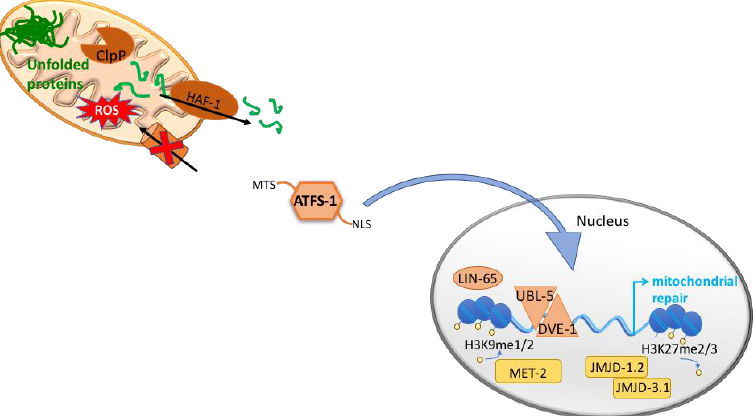
Figure 1. The mitochondrial unfolded protein responses, UPR mt . In order to maintain mitochondrial proteostasis, the UPR mt is activated and induces the expression of mitochondrial chaperones and proteases. In C. elegans , unfolded proteins within the mitochondrial matrix are cleaved by the mitochondrial protease, ClpP, and the resulting peptides are exported to the cytoplasm through the mitochondrial ATP-binding cassette (ABC) transporter, HAF-1. ATFS-1 presents a mitochondrial targeting sequence (MTS) and a nuclear localization signal (NLS). Under normal conditions ATFS-1 is imported to the mitochondria where it is degraded by the Lon protease. However, during stress ATFS-1 is translocated to the nucleus due to defective mitochondrial import and to the accumulation of peptides in the cytosol. Once in the nucleus, ATFS-1 together with DVE-1 and UBL- 5, induce the expression of genes involved in restoring mitochondrial homeostasis. In addition, mitochondrial stress causes changes in chromatin structure. In particular, mitochondrial stress induces the histone methyltransferase MET-2 and the nuclear co-factor LIN-65 for the di-methylation of the histone H3K9. Moreover, two demethylases, JMJD-1.2 and JMJD-3.1, have been shown necessary for the induction of the UPR mt